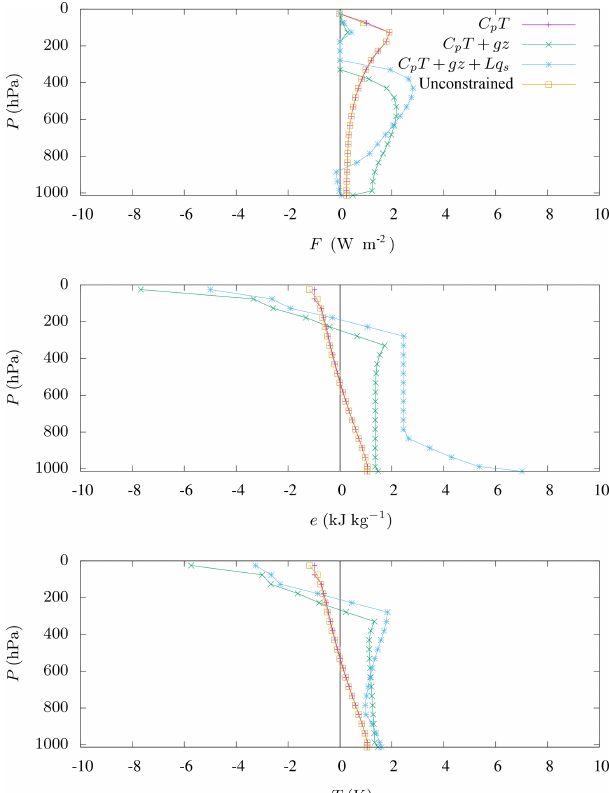
Figure 6. Differences in convective energy flux F , specific en- ergy e , and temperature T between [ CO 2 ] = 560ppm and [ CO 2 ] = 280ppm for tropical atmospheric composition by McClatchey et al. (1972) represented for constrained model with e = C p T , e = C p T + gz , and e = C p T + gz + Lq s , and for the unconstrained model by Herbert et al.